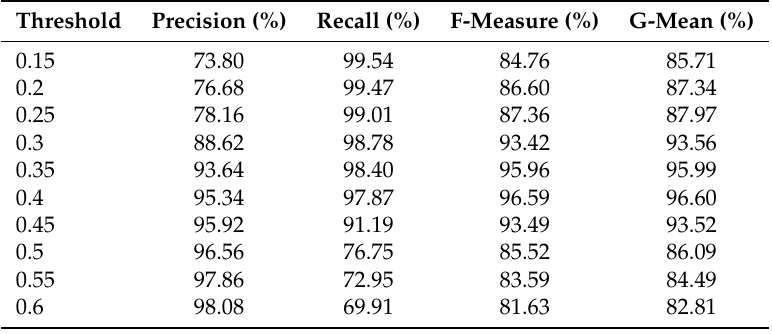
Table 2. The results of the human detection (considering different